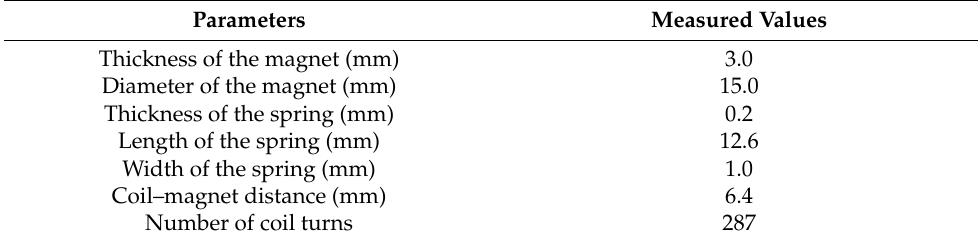
Figure 11. Photos of ( a ) the integration of the miniaturized reliability test system with controlled environment parameters and the piezo shaker, ( b ) the energy harvester in the test chamber and ( c ) the energy harvester device. Table 3. Parameters of the electromagnetic vibration energy